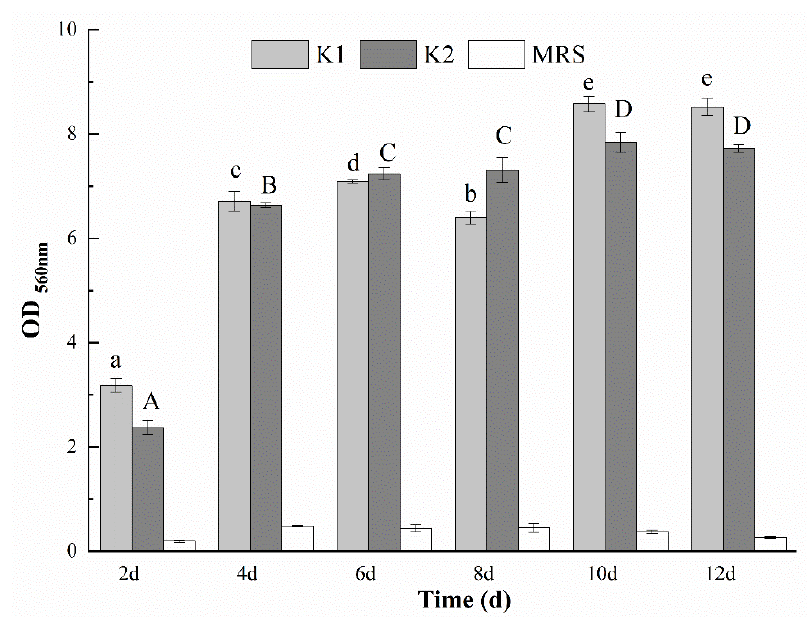
Figure 4. Biofilm-forming ability of kefir grains in the medium with different days. Values with different letters within each cultivation time and OD 560 nm value of K1 (a–e) and K2 (A–D) are significantly different ( p <